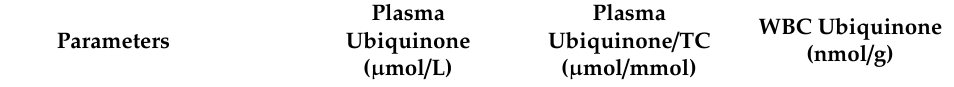
Table 3. Correlations between ubiquinone status and oxidative stress, antioxidant capacity, and glycemic parameters after